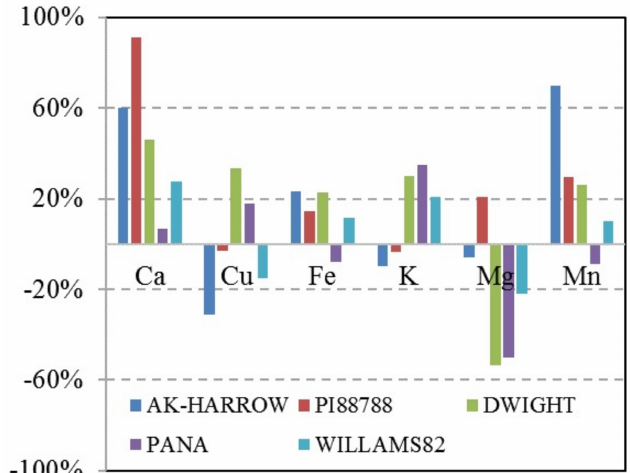
Figure 5. Variation in mineral nutrient concentration within five soybean genotypes. Differences were calculated for major elements by subtracting the concentration values on 13 August 2014 from measurements on 17 July